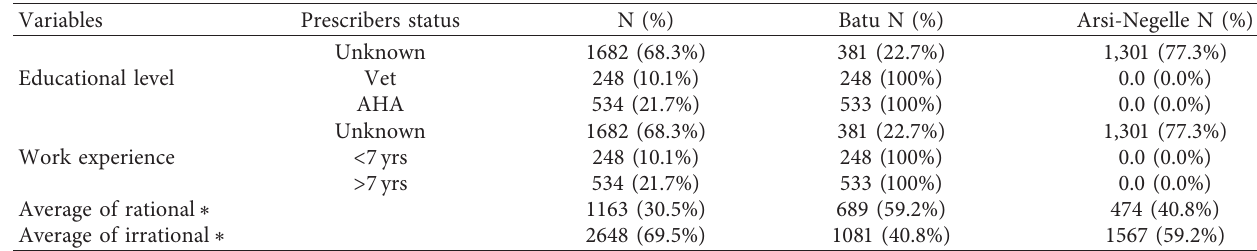
Table 4: Relationship between prescriber’s status and drugs used across the two